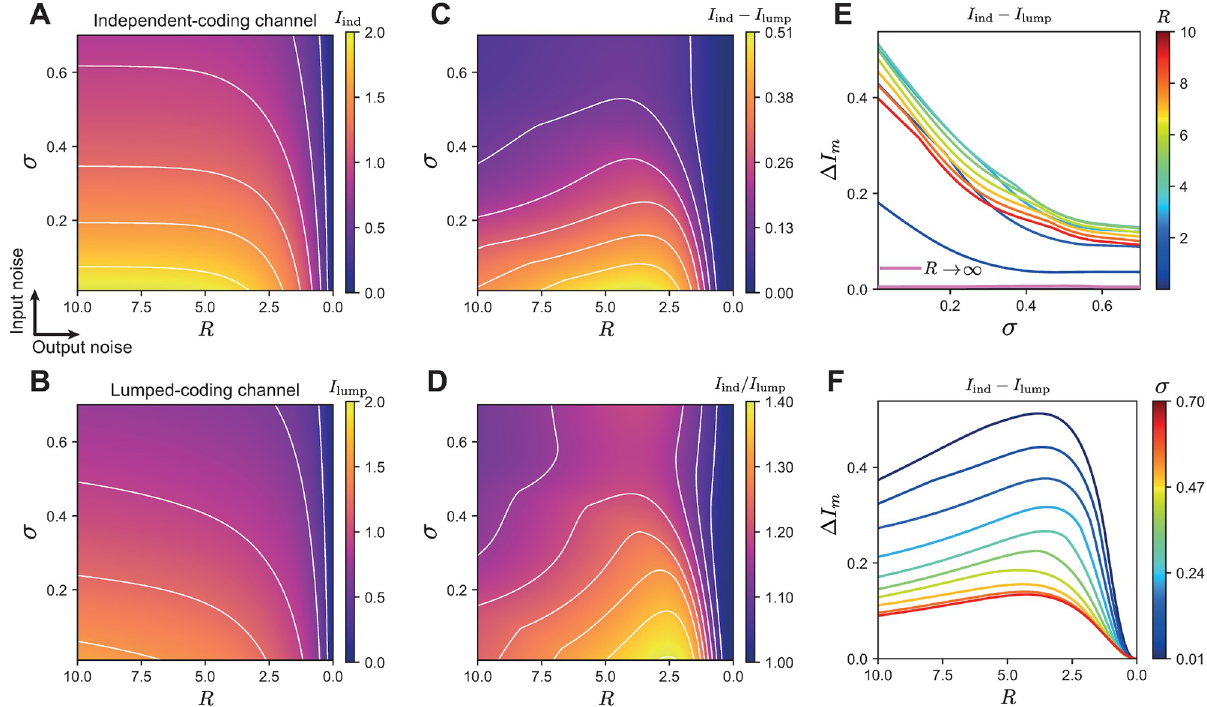
Fig 3. Maximized mutual information for the lumped- and independent-coding channels for a population of three neurons. A . Information of the independent-coding channel for different combinations of output noise R and input noise σ . Contours indicate constant information. B . Information of the lumped-coding channel. C . Absolute information difference between the two coding channels. D . Information ratio between the two coding channels. Both C and D show a region of intermediate output noise where the independent-coding channel substantially outperforms the lumped- coding channel. E . Information difference depending on input noise σ for various levels of output noise R , corresponding to vertical slices from C. We also include the special case of zero output noise, R ! 1 . F . Information difference depending on output noise R for various levels of input noise σ , corresponding to horizontal slices from